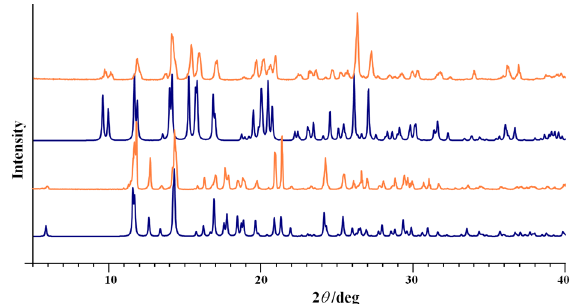
Figure 3. PXRD patterns of [MoO 2 (L)(MeOH)] polymorphs: ( top ) obtained by reaction of H 2 L with [MoO 2 (acac) 2 ], ( bottom ) obtained by sample obtained upon deprotonation of [1H]Cl · MeOH. The orange lines indicate patterns obtained by powder diffraction, while the blue lines indicate patterns calculated from the X-ray single-crystal structures of the corresponding polymorphs.